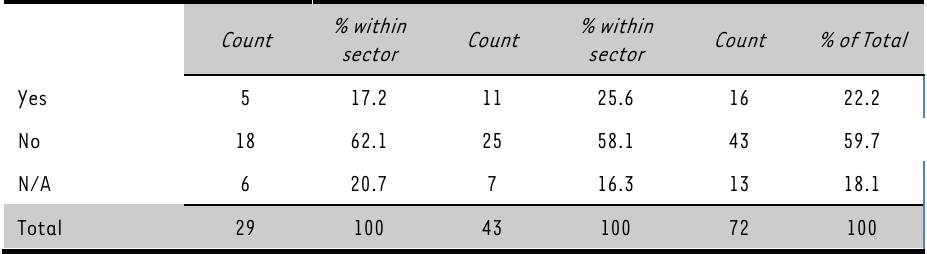
Organisation’s consideration of outsourcing the whole or part of their internal auditing function by sector Count